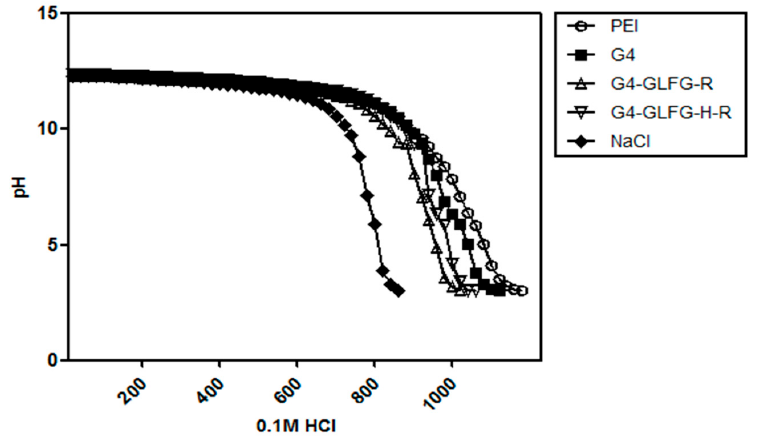
Figure 6. Acid–base titration of G4-GLFG-R and G4-GLFG-H-R.